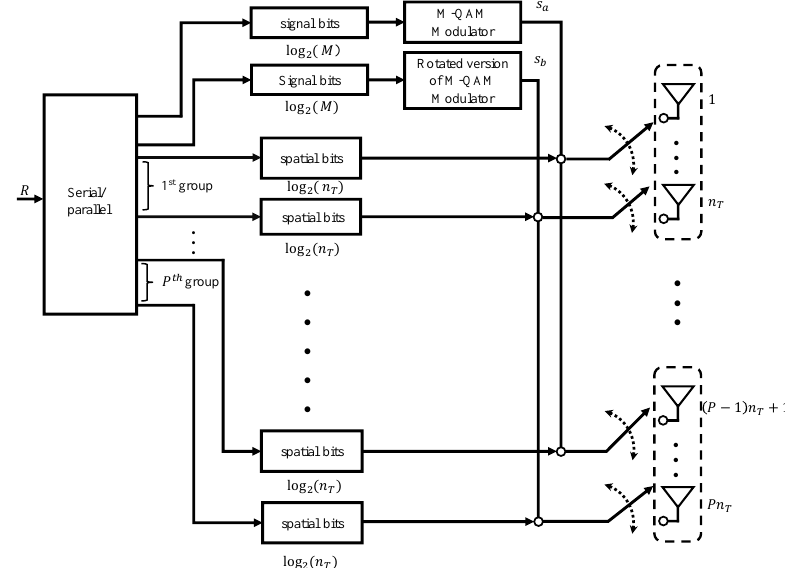
Figure 1. A block representation of parallel complex quadrature spatial modulation (PCQSM) with P antenna